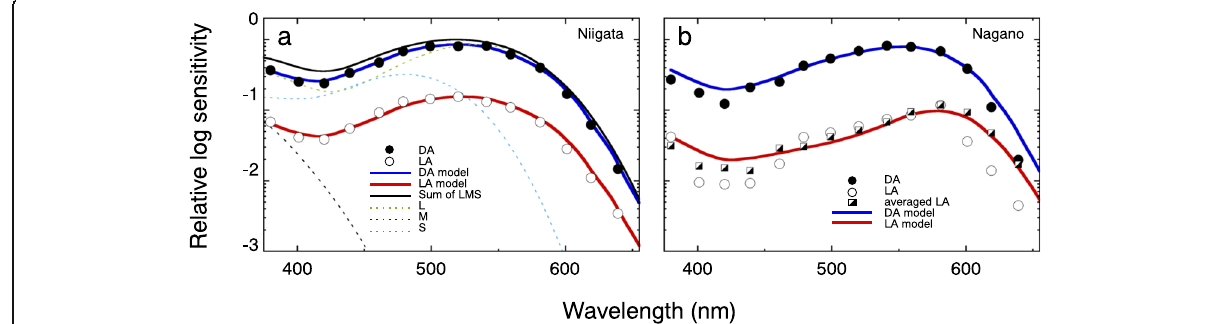
Fig. 5 Modelled spectra of dark- (blue line) and light- (red line) adapted eyes with the recorded spectral sensitivities shown in Fig. 4 b and c (circles). Model fits were performed over the wavelength range for which pigment spectra were available. For coefficients, see Table 1. a Niigata strain. Dotted spectra show visual pigment templates (grey, S; blue, M; green, L) with their relative peak values according to f i . The solid black line denotes the sum of these three spectra, i.e. the sensitivity in the absence of screening pigment. b Nagano strain. For illustration (because the light-adapted spectrum is based on a single individual and may therefore be noisy), half-filled squares show the averaged spectral sensitivity shown in Fig. 4 a with open triangles, scaled to the appropriate amplitude